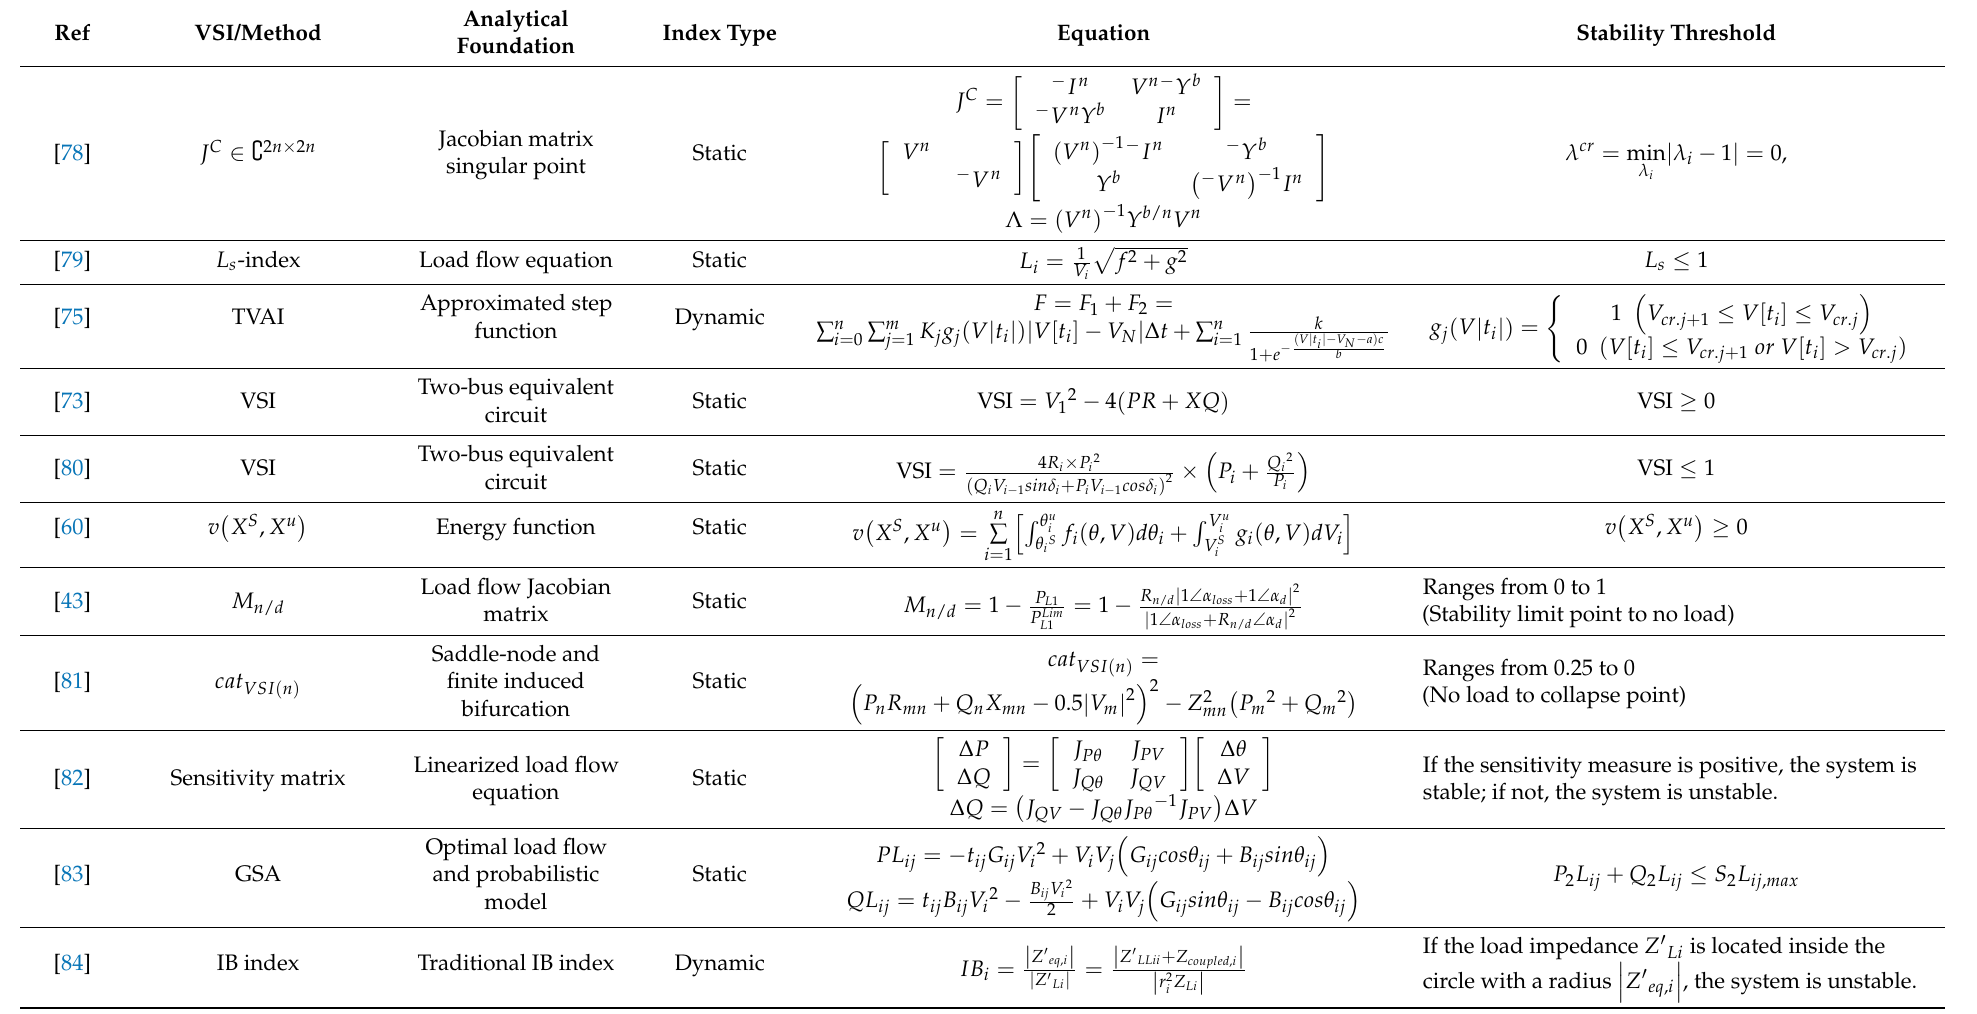
Table 1. Summary of voltage stability analysis methods and